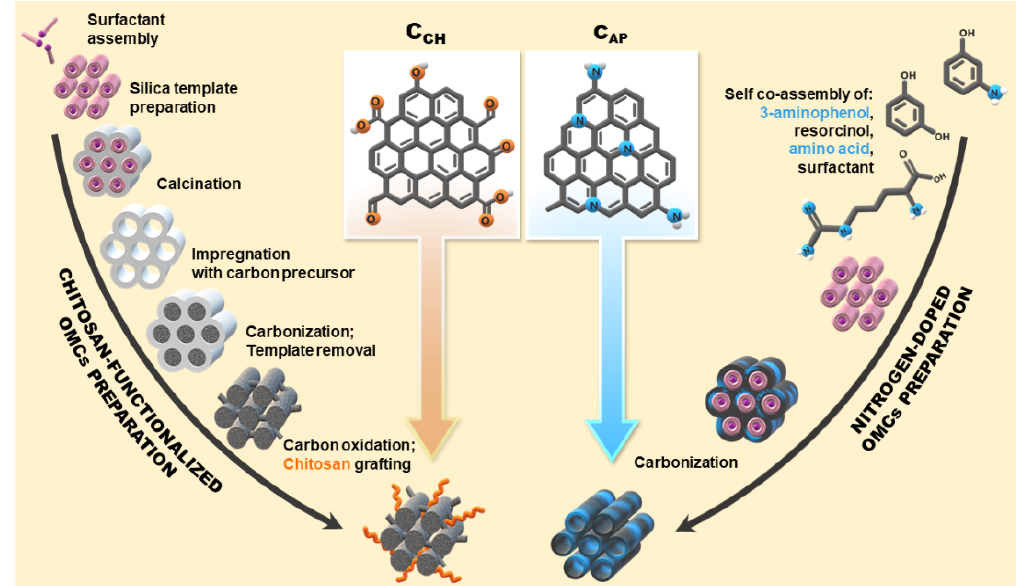
Figure 1. Scheme representing syntheses of carbon carriers via different routes. On the left: chitosan-modified ordered mesoporous carbons (C CH ) via the hard-templating method, followed by oxidation and chitosan grafting. On the right: nitrogen-doped ordered mesoporous carbons (C AP ) through soft-templating method with 3-aminophenol and amino acid ( L -arginine) as N-dopants.